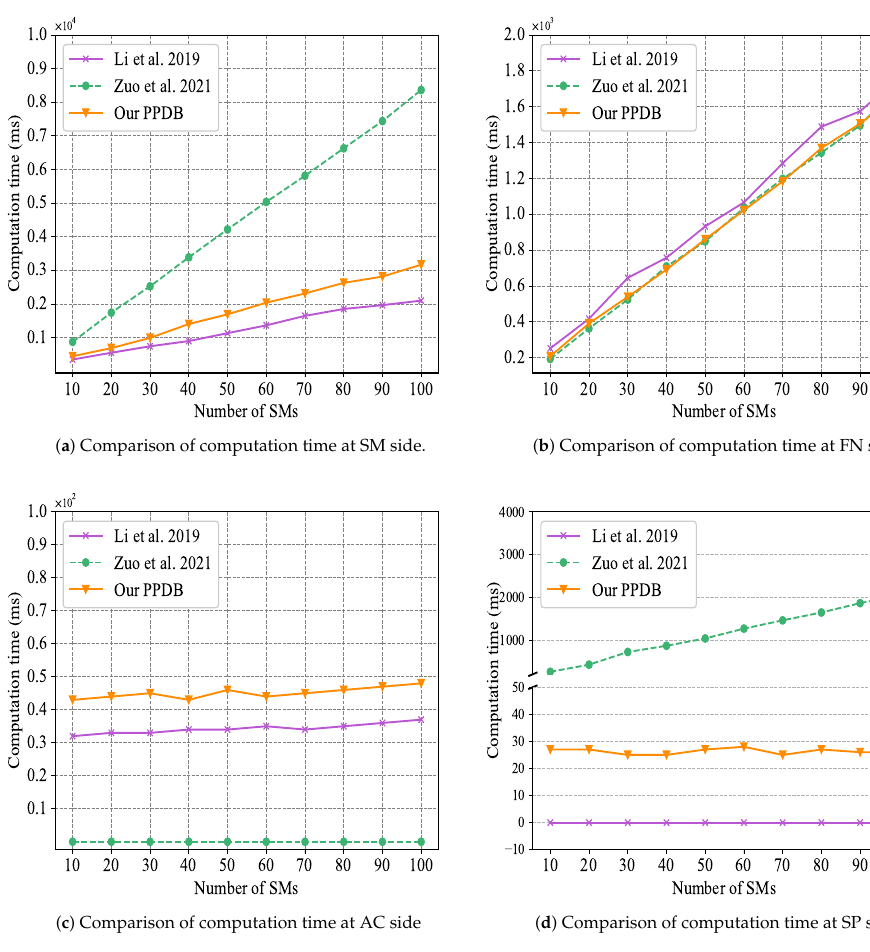
Figure 7. Comparison of computation time of Li et al. [23], Zuo et al. [27] and our PPDB at each side.